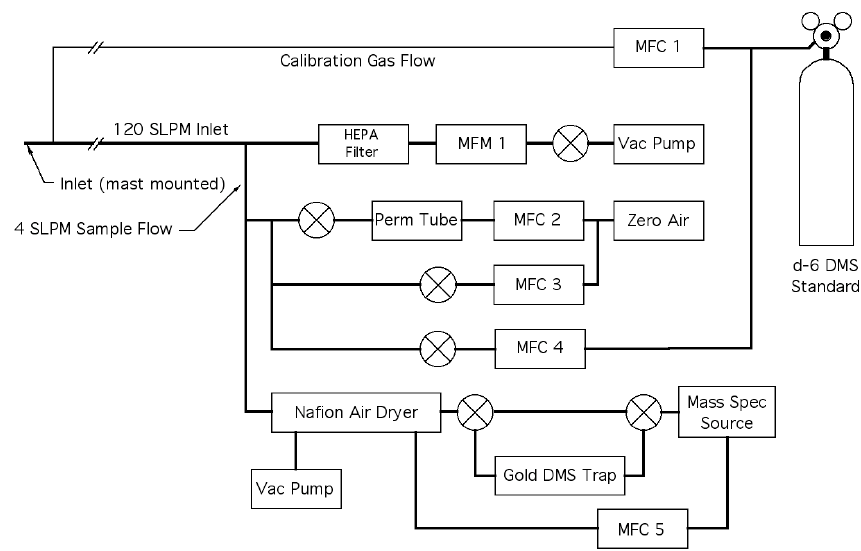
Fig. A3. Gas flow system for sampling and calibration. A high efficiency particle filter (HEPA) is used on the main manifold flow to protect the mass flowmeter MFM 1 from salt aerosols. Three mass flow controllers (MFC 2-4) are included to facilitate calibration of the compressed gas standard using a permeation device. Recycle flow is used for the Nafion dryer outer-jacket, which operates at reduced pressure, improving dryer